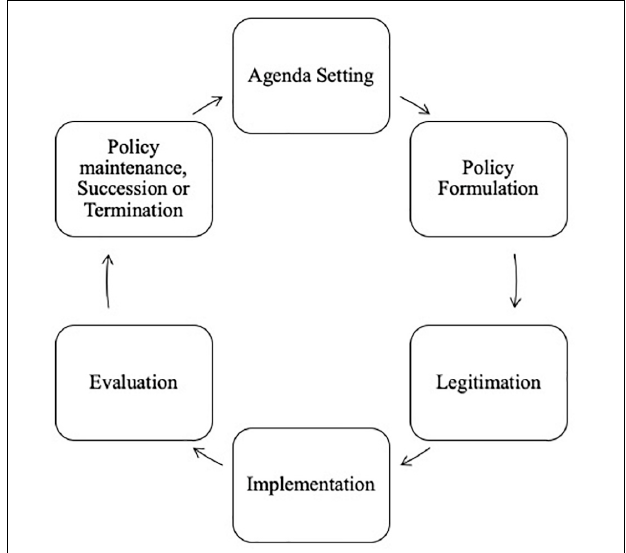
FIGURE 2 | Theories of the policy cycle. Adapted from Jann and Wegrich (2007).